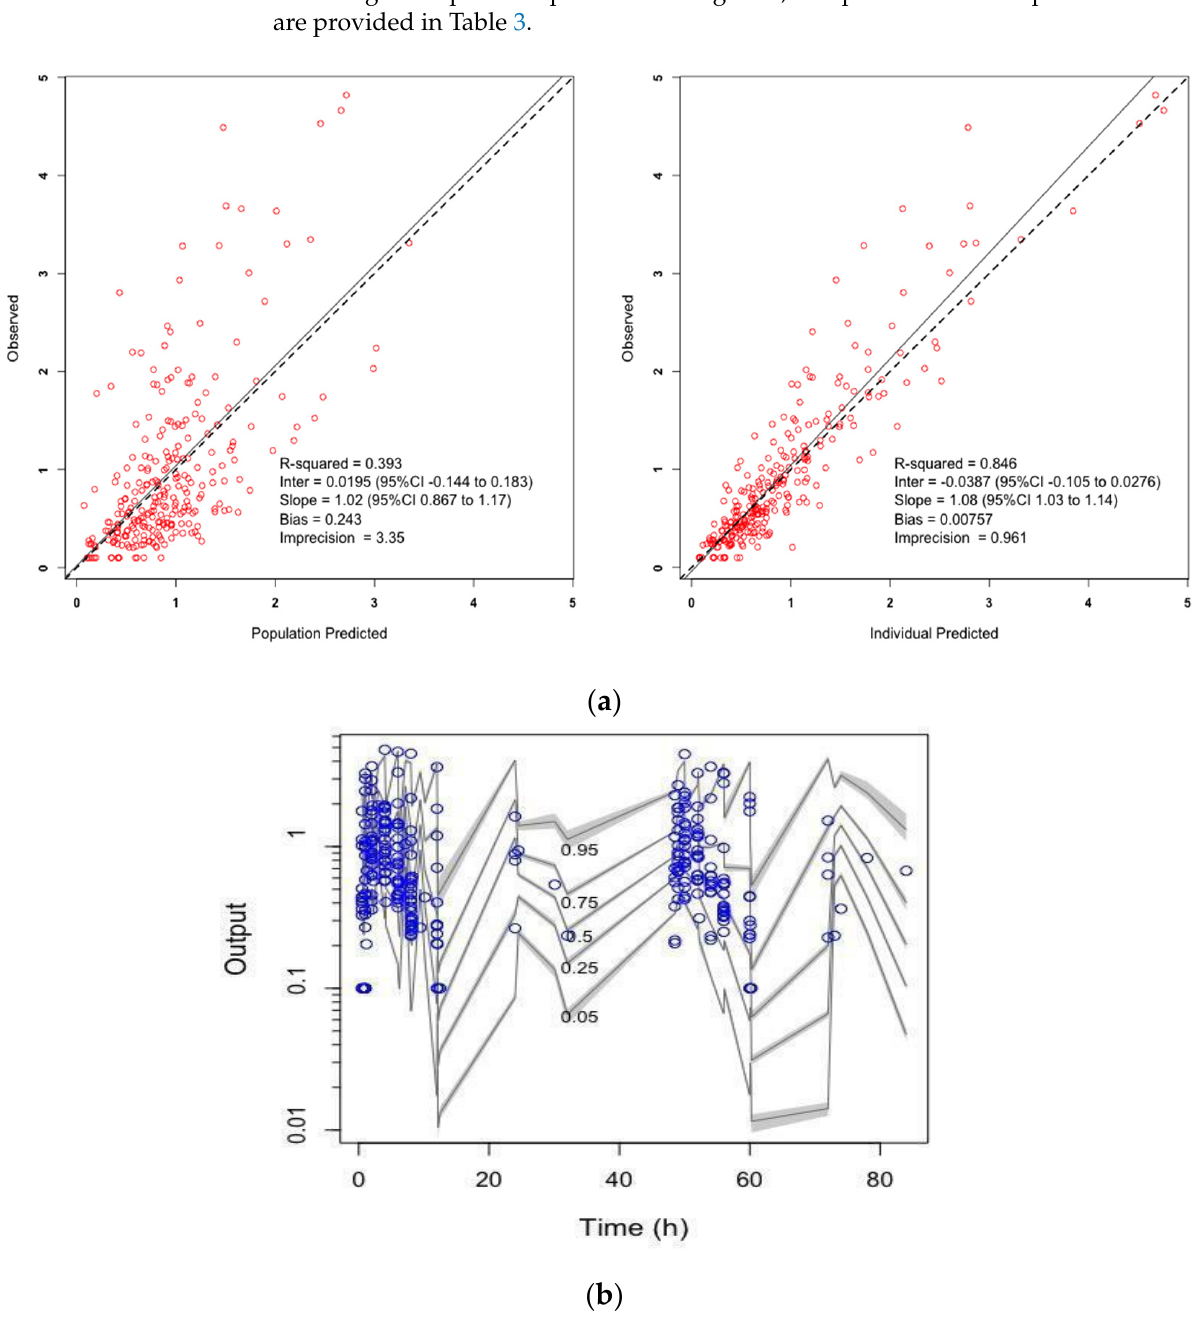
Figure 1. ( a ) Observed versus population-predicted (left) and individual-predicted (right) ethambutol concentrations diagnostic plots and ( b ) visual predictive